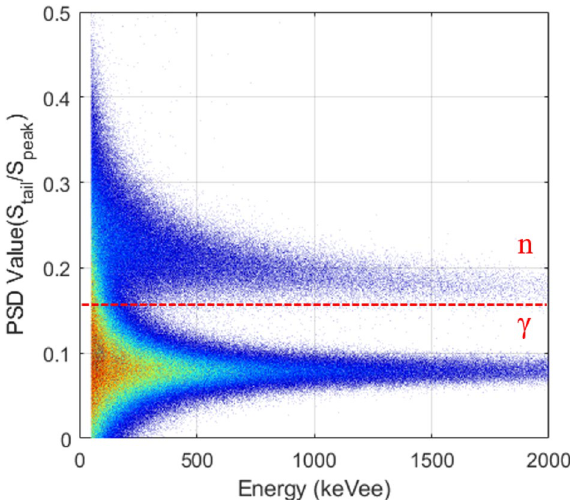
Figure 4. PSD plot for 1,800,000 pulses with an energy threshold of 50 keVee produced by the stilbene-SiPM array module measuring a 3.5 × 10 5 n/s 252 Cf spontaneous fission source located 50 cm away from the front of detector. The dashed PSD cutoff line is established by the